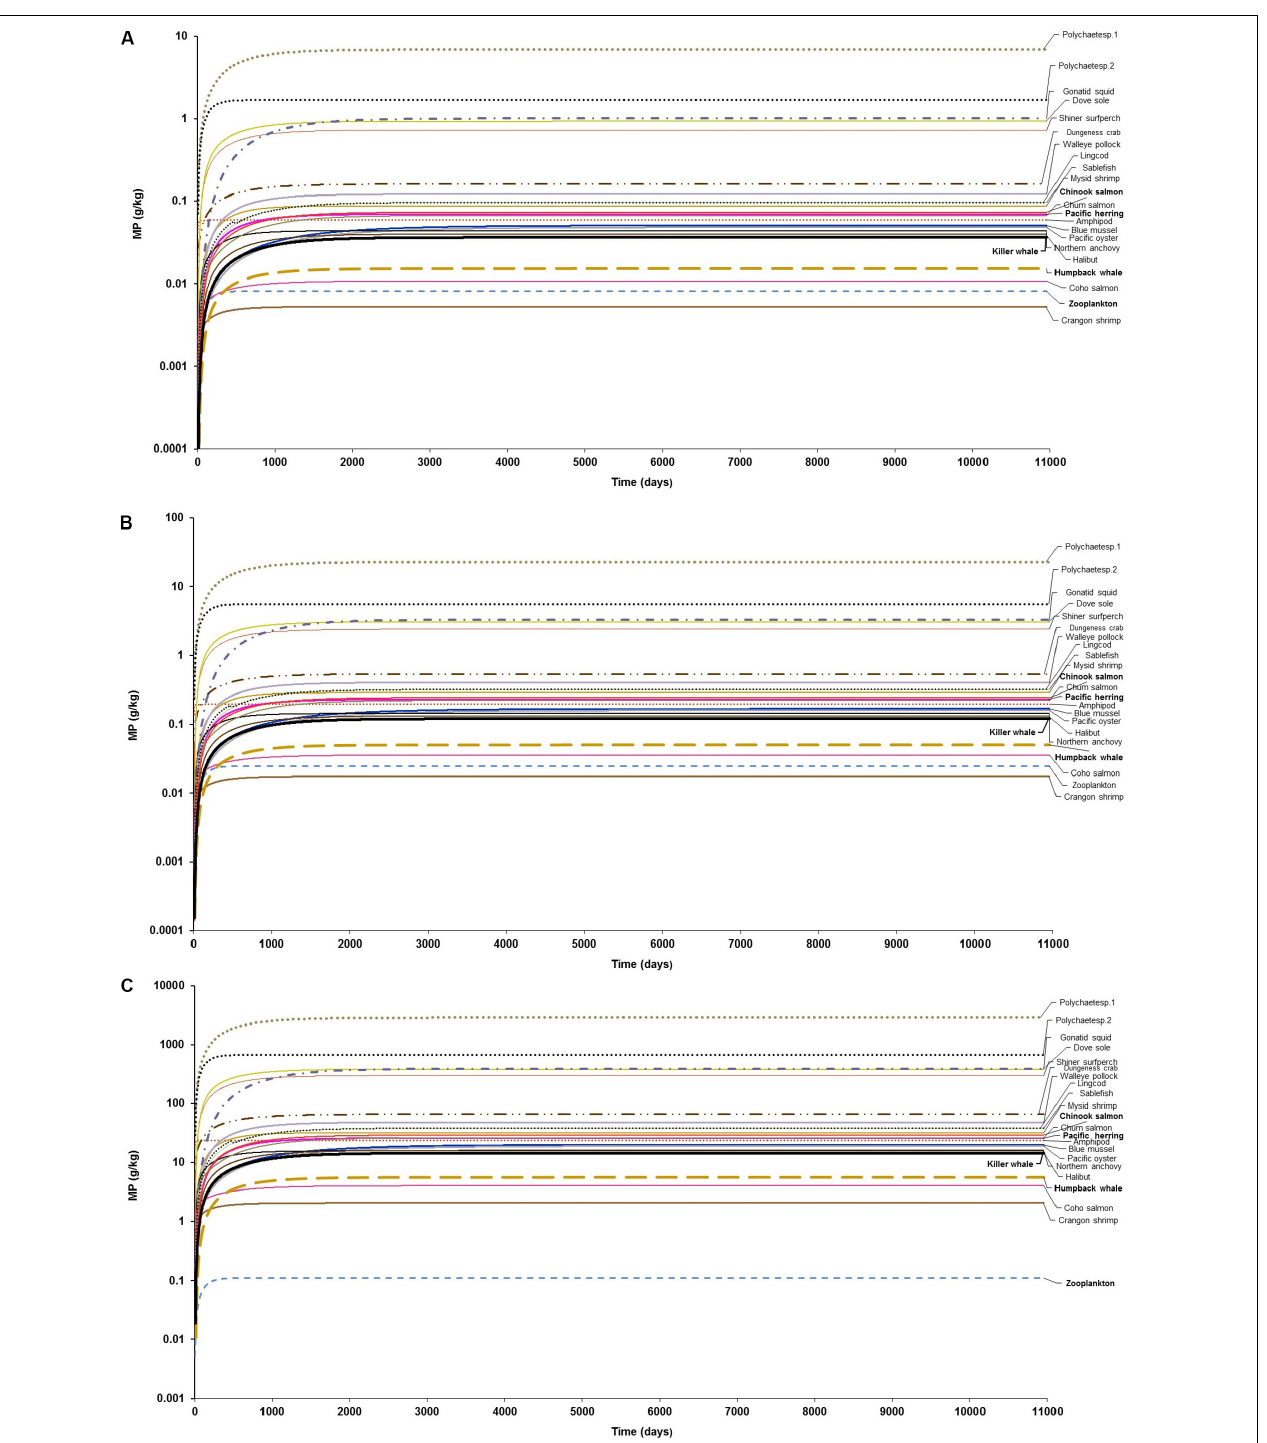
FIGURE 1 | Foodweb model simulations showing the projections of microplastics (MPs) bioaccumulation in organisms of the marine mammalian food web for the three abiotic concentration scenarios: (A) low concentration (scenario 1): seawater = [0.003 g/L] and sediment = [0.266 g/kg dw], based on the empirical data by Collicutt et al. (2019); (B) moderate concentration (scenario 2): seawater = [0.010 g/L]; and, sediment = [0.886 g/kg dw], based on the empirical data by Desforges et al. (2014) and Kazmiruk et al. (2018); and (C) high concentration (scenario 3): seawater = [0.04 g/L]; an, sediment = [111 g/kg dw], based on the empirical data by Desforges et al. (2014) and Kazmiruk et al. (2018). The simulations for the bioaccumulation include the elimination rates, and growth dilution for most organisms based on the literature reported elsewhere (see Supplementary Table S1 ). For zooplankton, as the key trophic level for the initial uptake of microplastics a k E = 0.143/d (i.e., retention time = 7 days) was used as a least conservative scenario, based on the study by Cole et al. (2013).